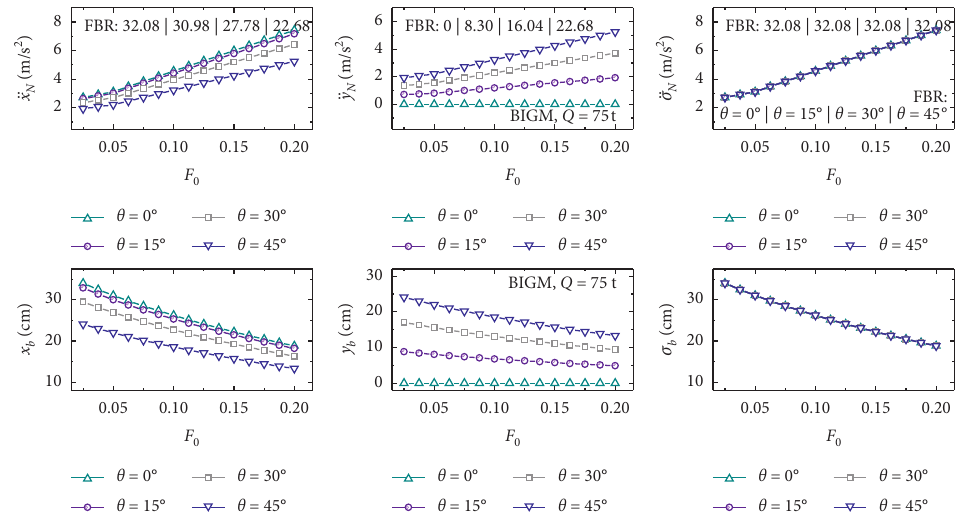
Figure 8: The response of a four-story building isolated by the N-Z system under NF earthquakes, FF earthquakes, and R-FBI under multiple hazards. The average values of the response quantities obtained under IV1979, LP1989, and NR1994 earthquake ground motions are taken to obtain representative trends for the NF earthquake case. Similarly, the average values of the response quantities obtained under IV1979F, LP1989F, and NR1994F earthquake ground mo-